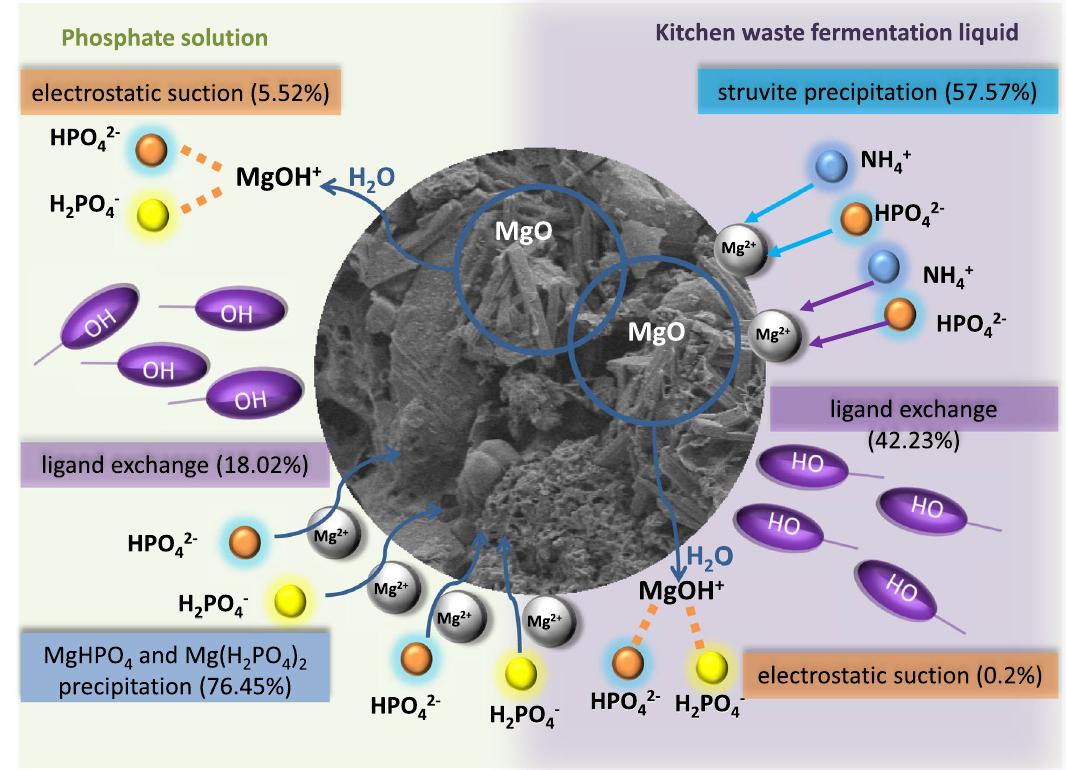
Fig. 8 Illustration of the mechanisms of P adsorption in the synthetic phosphate solution and the kitchen waste fermentation